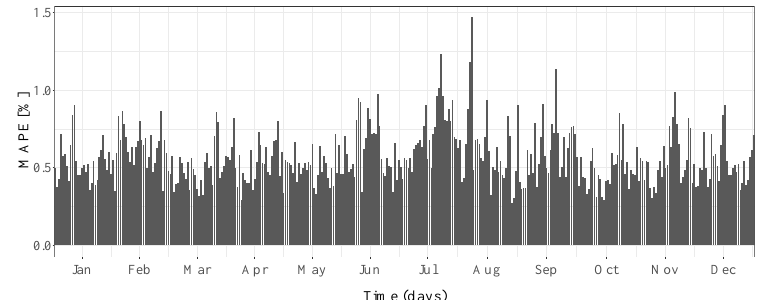
Figure 9. Mean daily MAPE for GENESE zone, for 2013.